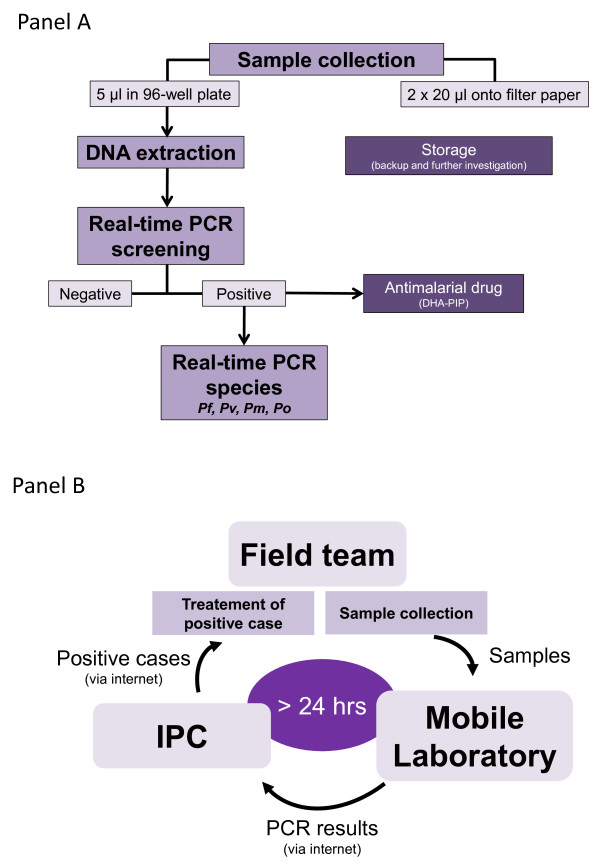
The overview of the process used for high-throughput malaria PCR detection in the field (Panel A), including samples and data management (Panel B).